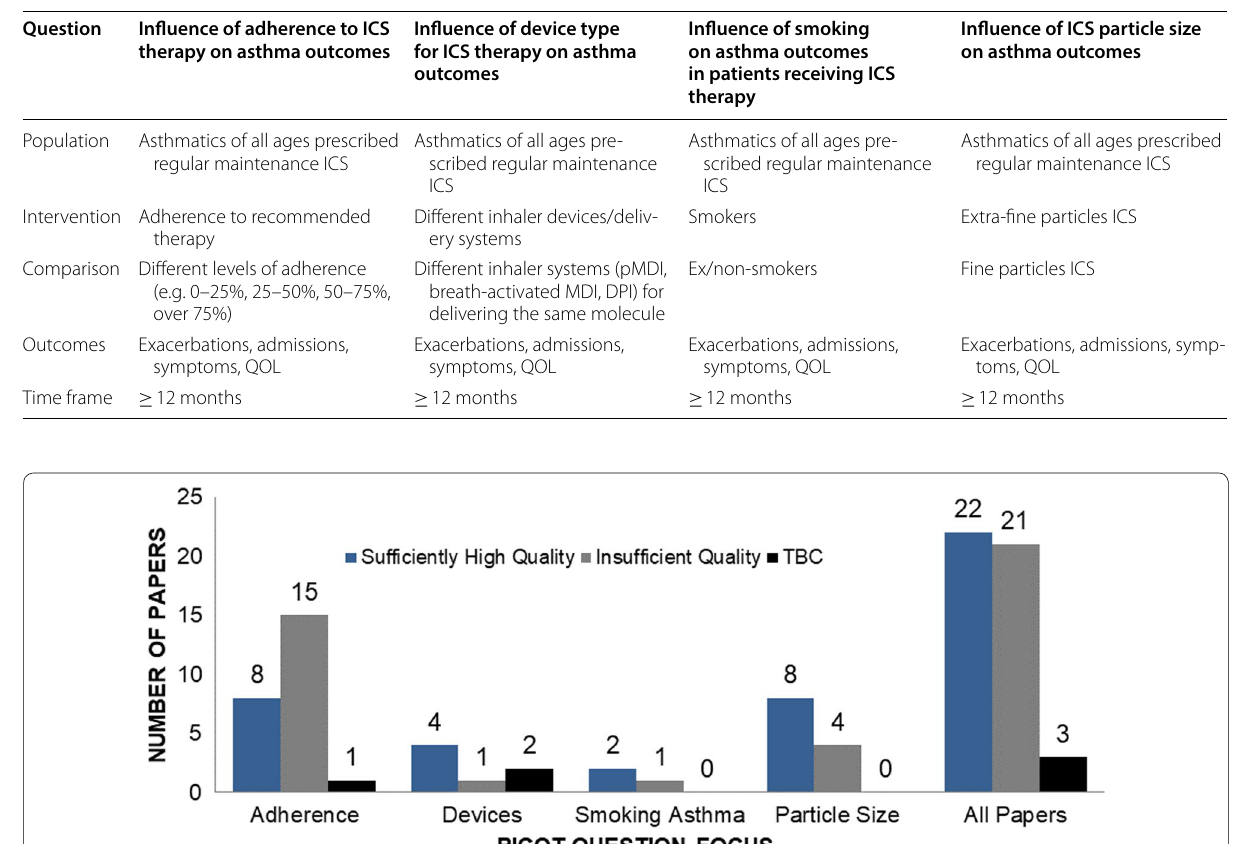
Fig. 4 distribution of papers by quality rating within selected PICOT questions. TBC refers to a minority of papers that got only one rating, so that final rating remained to be